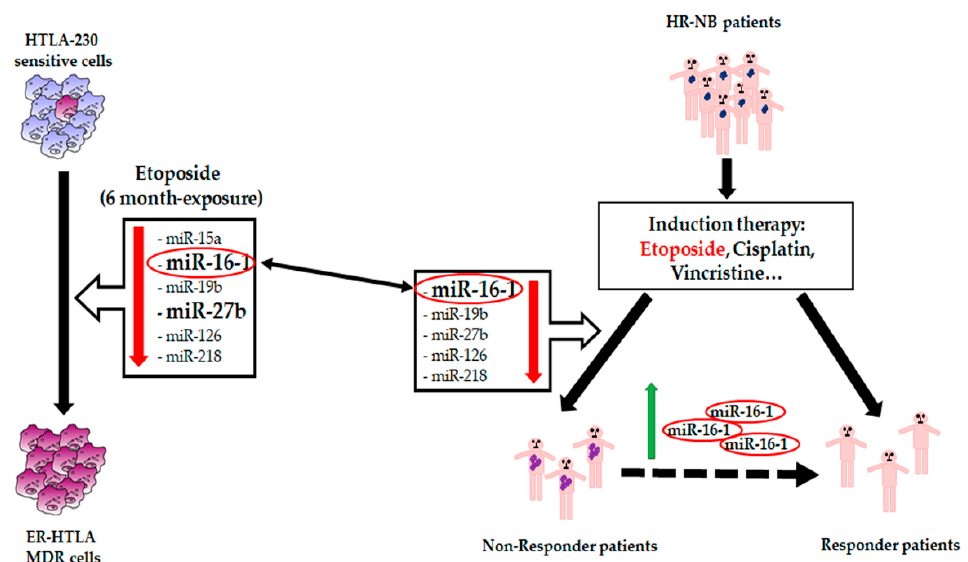
Figure 7. Role of miR-16-1 in NB chemoresistance. The acquisition of chemoresistance in multidrug resistant (MDR) cells and in high-risk (HR) patients is characterized by miR-16-1 down-regulation, suggesting a potential role of miR-16-1 as a chemosensitizer.